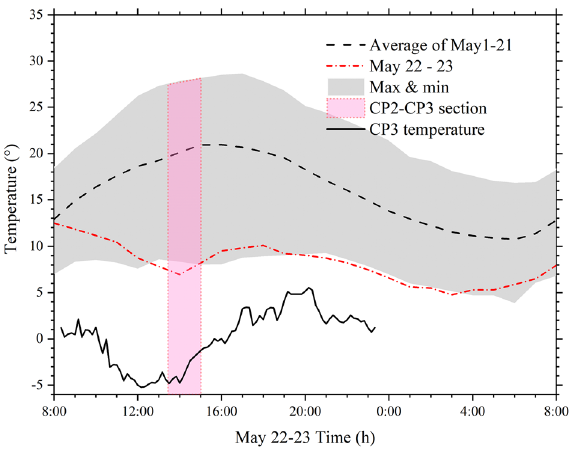
Figure 4. The temperature of Baiyin and CP3 on race day and the average temperature, maximum and minimum temperature of 21 days before the competition, Baiyin Weather Station.